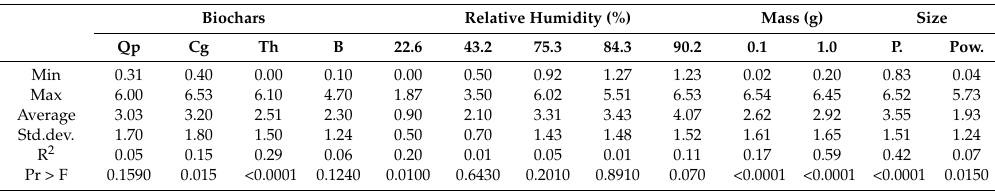
Table 5. Summary statistics for the linear regression model of T ( ◦ C) vs. W (%) for each qualitative variable. P. = piece; Pow. =